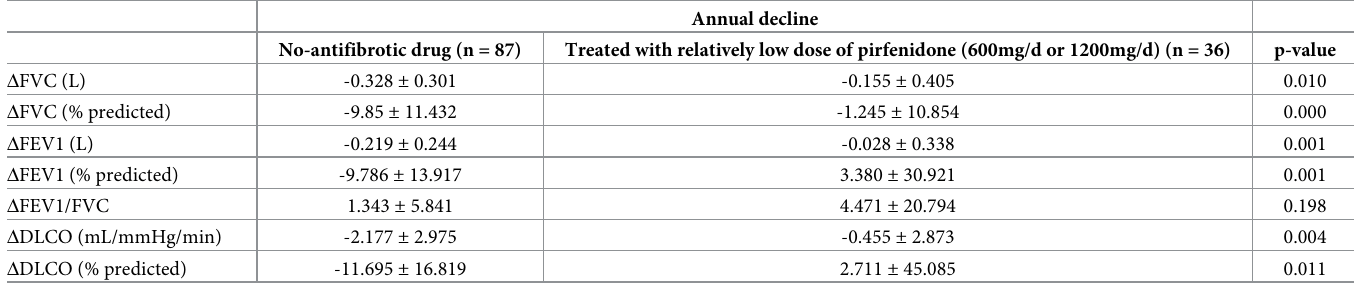
Table 6. Comparison of annual decline in pulmonary function between patients who were not treated with antifibrotic drugs and patients who were treated with relatively low dose of pirfenidone (600mg/d or 1200mg/d).